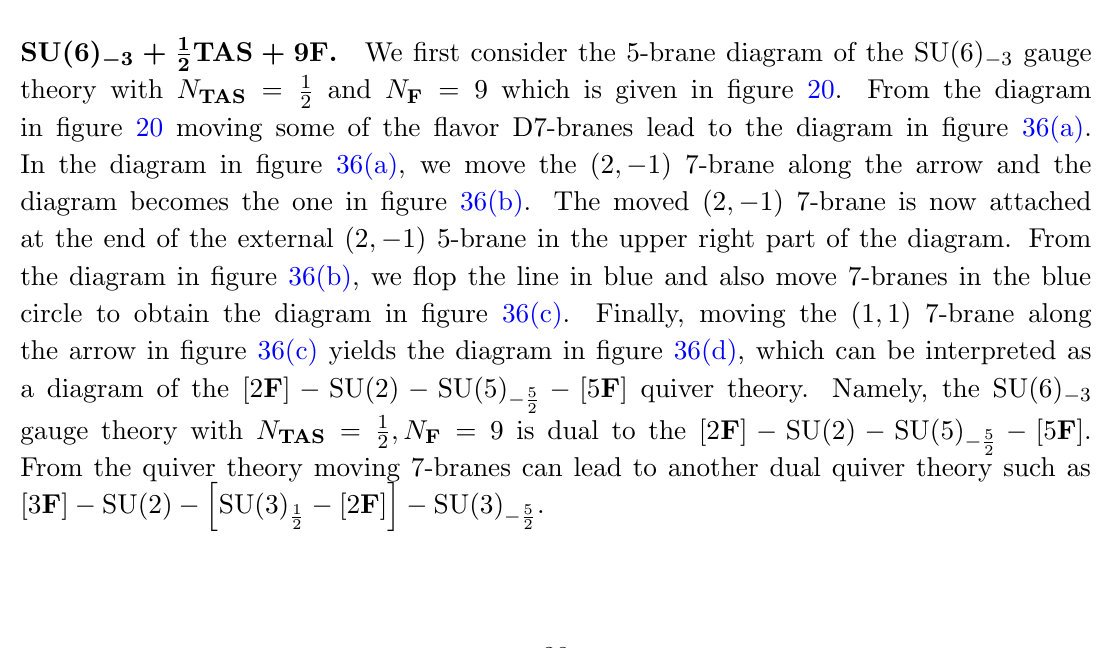
Figure 37 . (a) A 5-brane web diagram for the SU(6) gauge theory with N TAS = 1 (b) The diagram after moving the (1 ; 1) 7-brane along the arrow in (cid:12)gure 37(a). (c) The diagram after moving the (2 ; (cid:0) 1) 7-brane along the arrow in the diagram in (cid:12)gure 37(b). It gives the quiver theory SU(2) (cid:0) SU(5) 3 (cid:0) [4 F ]. (d) The diagram of the quiver SU(2) (cid:0) SU(5) 1 (cid:0) [7 F ; 1 AS ] by adding three (cid:13)avors and a hypermultiplet in the antisymmetric representation to the diagram in (cid:12)gure